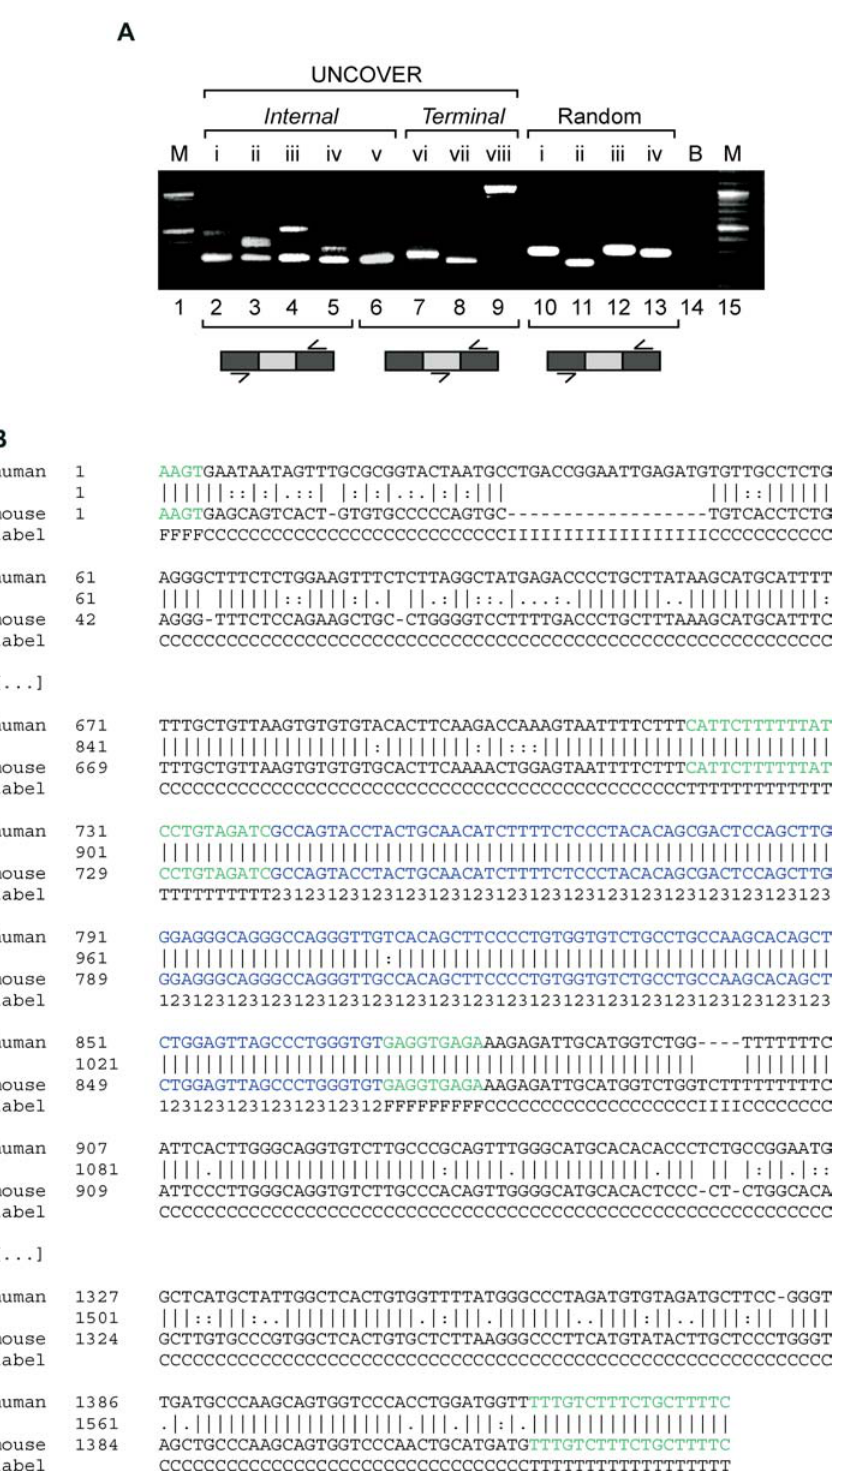
PLoS Computational Biology |